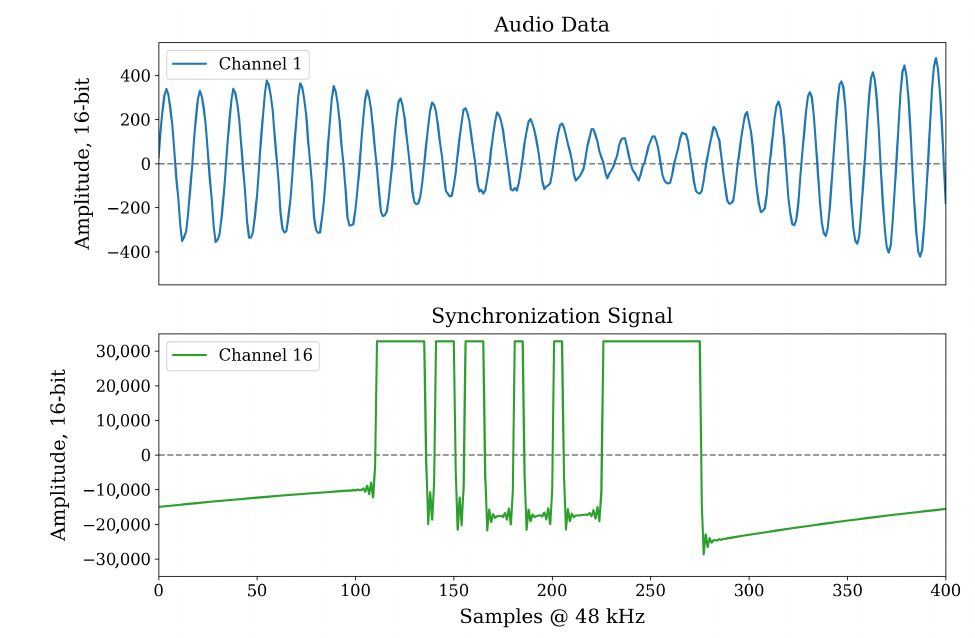
Figure 6. Example of a synchronization signal embedded into the last channel of audio data at a 120 Hz rate. It contains a serialized 32-bit timestamp that is shared across multiple sensors with 1 µ s accuracy using a 2.4 GHz radio module. High synchronization accuracy is required due to a high audio sampling rate of 48